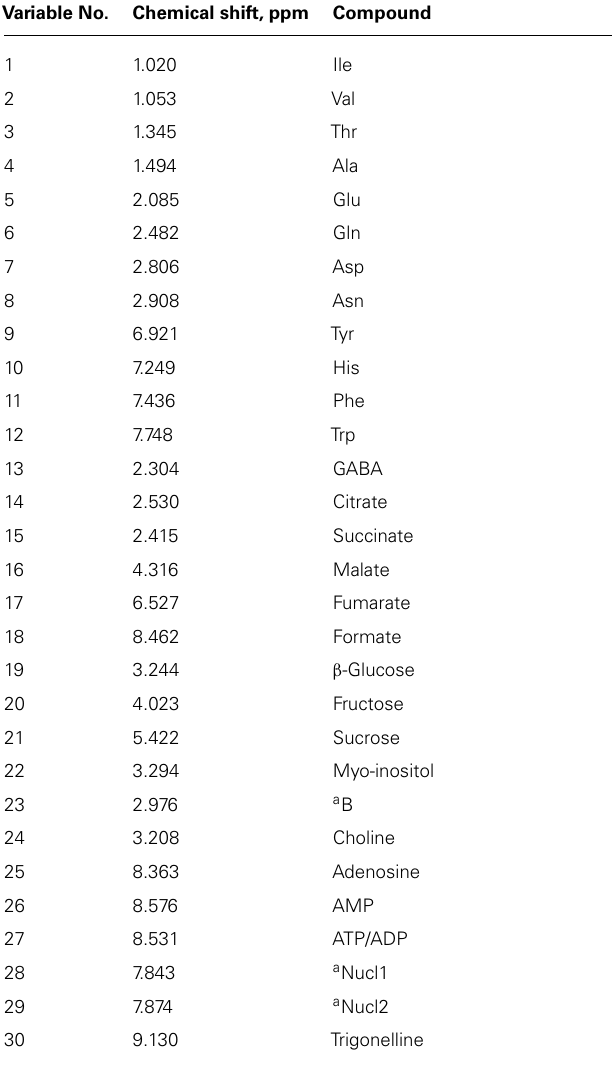
Table 1 | List of resonances and variables used for the evaluation of the various metabolites. Variable No. Chemical shift, ppm